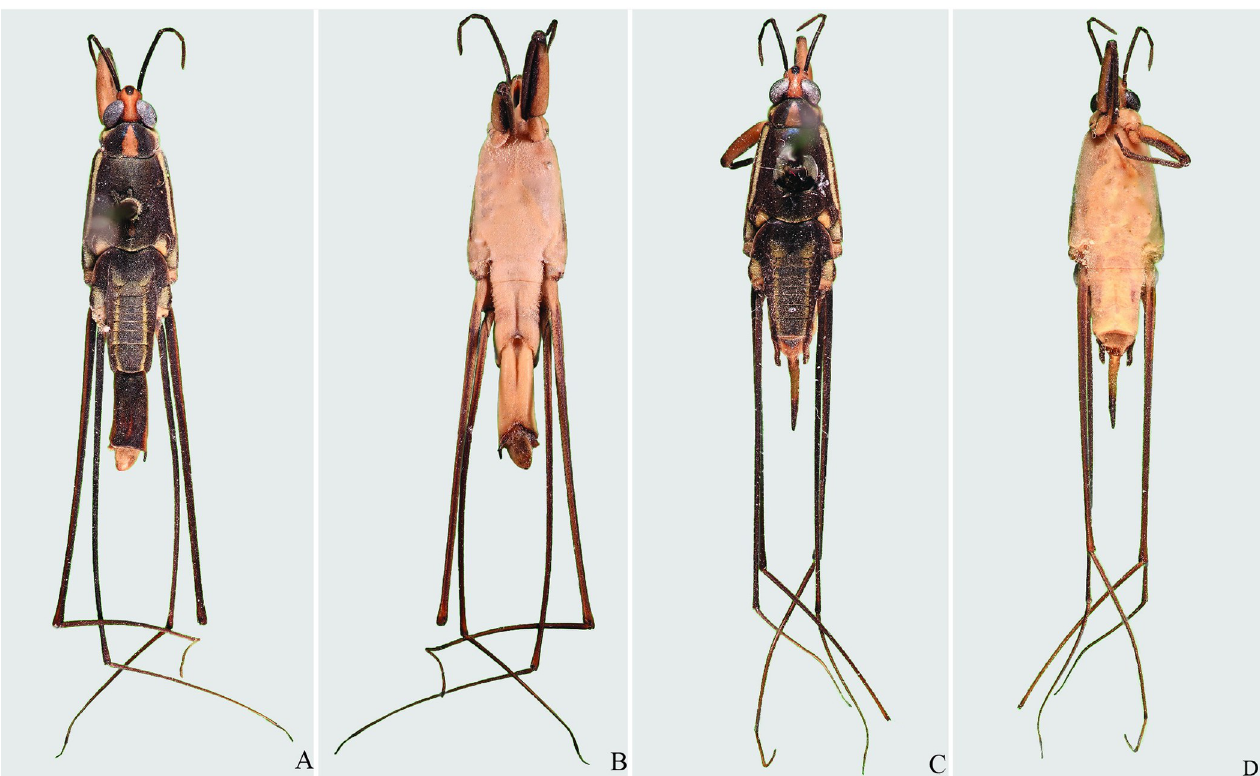
Fig 33. Potamobates vivatus . (A) Male, dorsal view; (B) male, ventral view; (C) female, dorsal view; (D) female, ventral view.